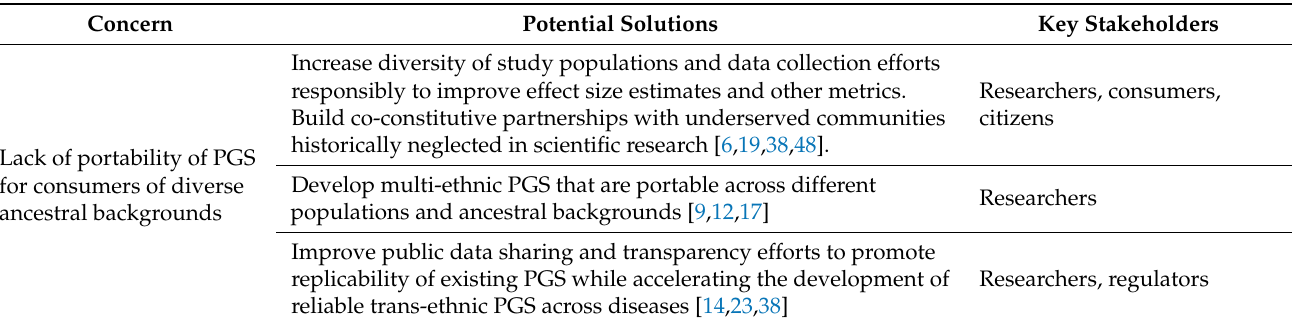
Table 2. Stakeholders and Potential Solutions for Key Issues in PGS-based Consumer Genetic